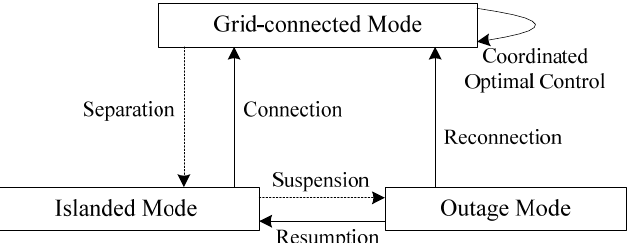
Figure 2. Finite state machine of micro ‐ grid operation modes.